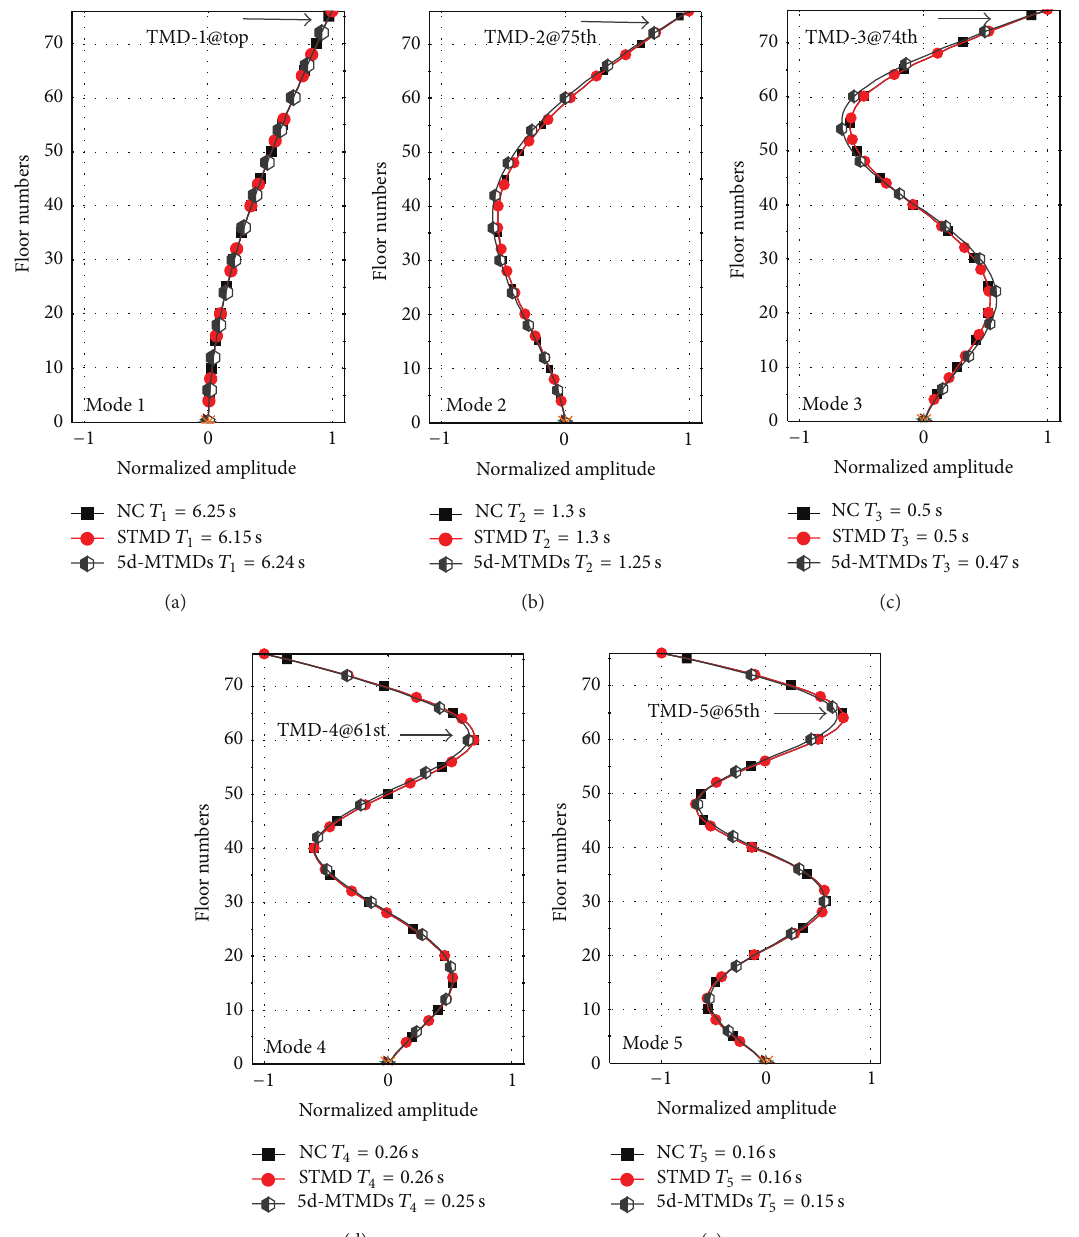
Figure 3: First five mode shapes of uncontrolled and controlled 76-storey benchmark